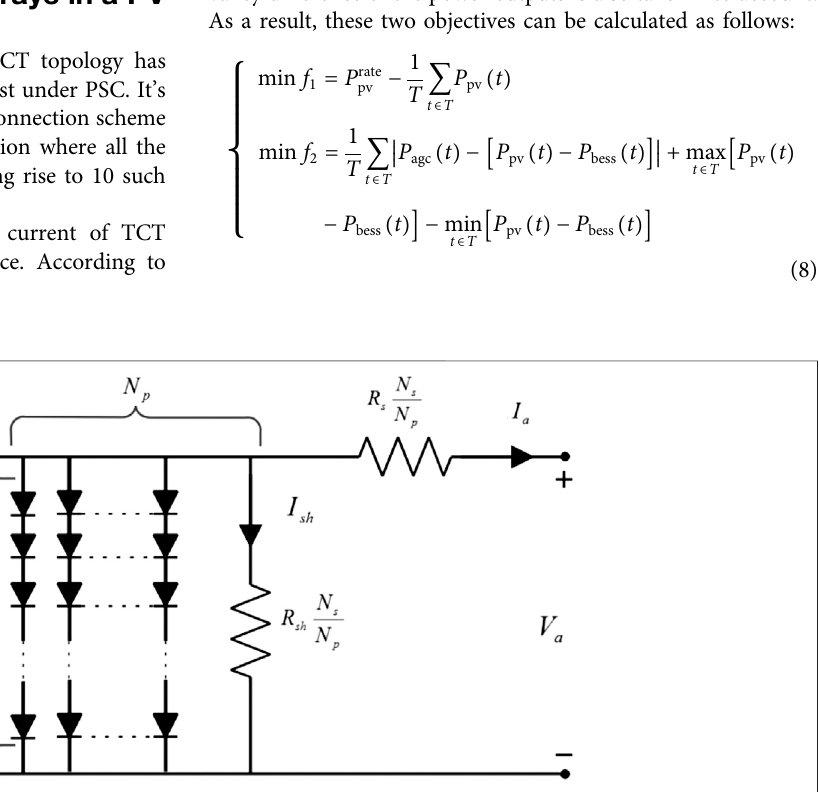
FIGURE 2 | Equivalent circuit of a PV array with N s × N p